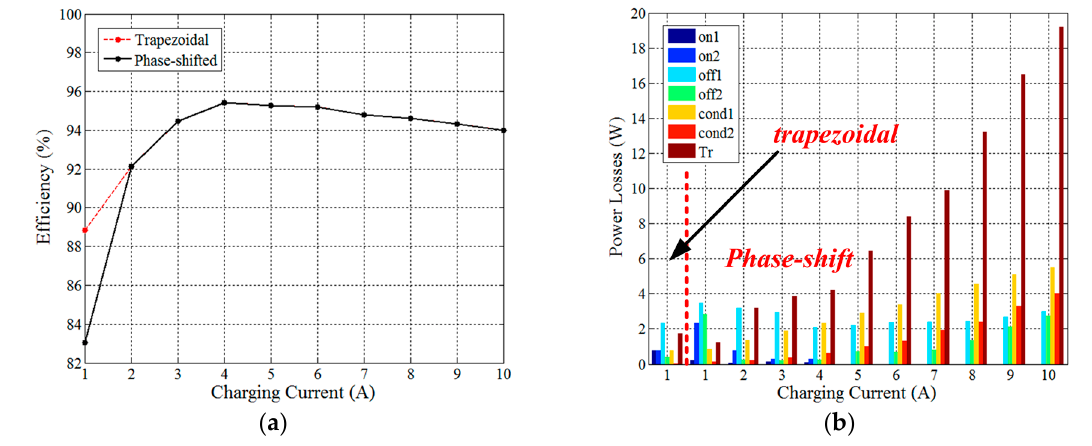
Figure 11. Analysis of efficiency and loss. ( a ) Measured efficiency of the converter with hybrid modulation; ( b ) Histogram of the power loss.